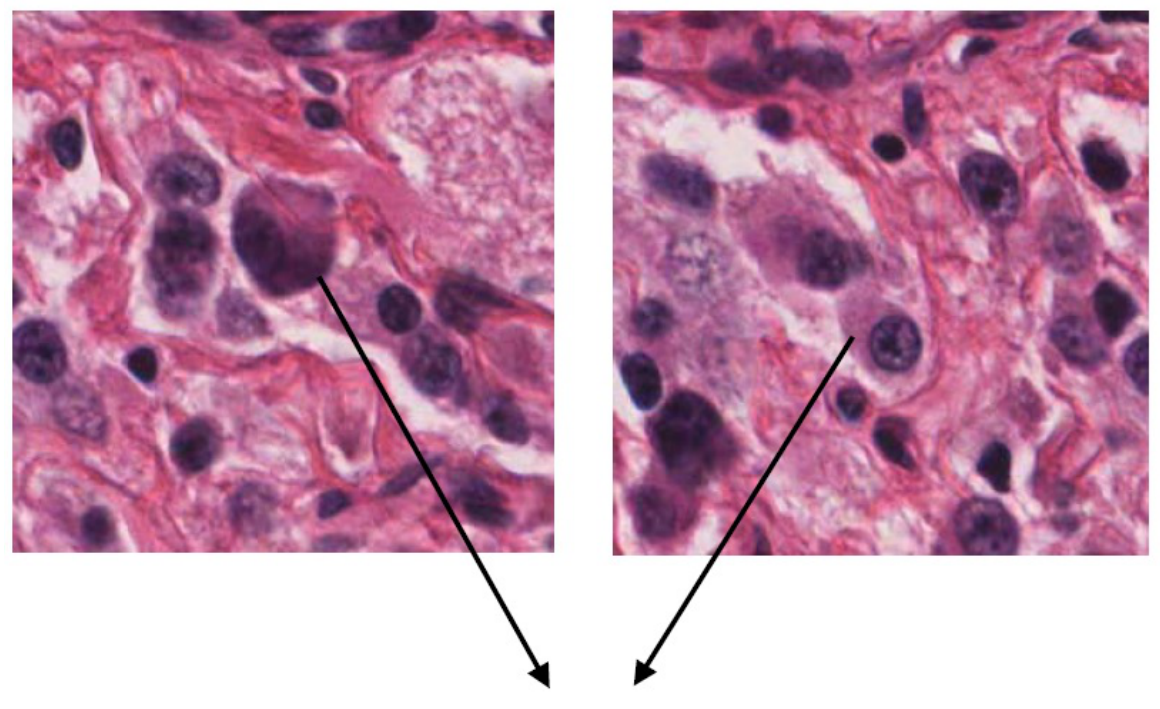
Figure 1. High intra-class variation in the size of the neuroblast